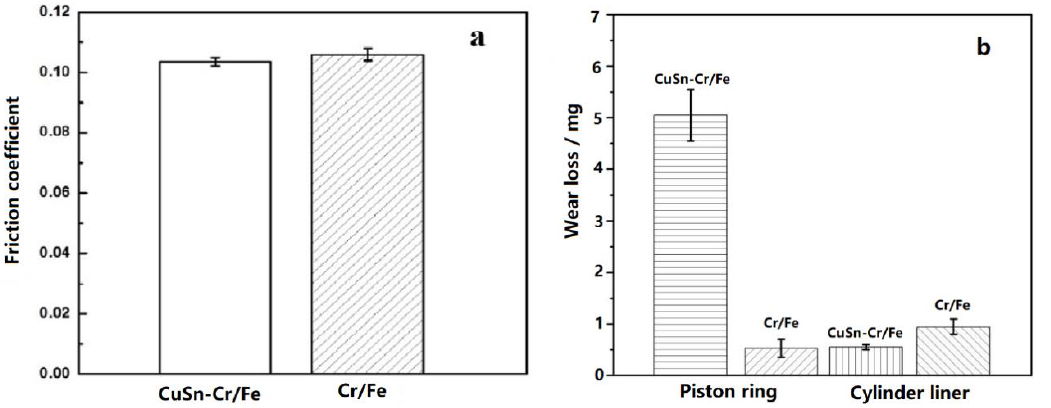
Figure 7. Friction coefficient ( a ) and wear loss ( b ) of the CuSn-Cr/Fe and Cr/Fe pairs.